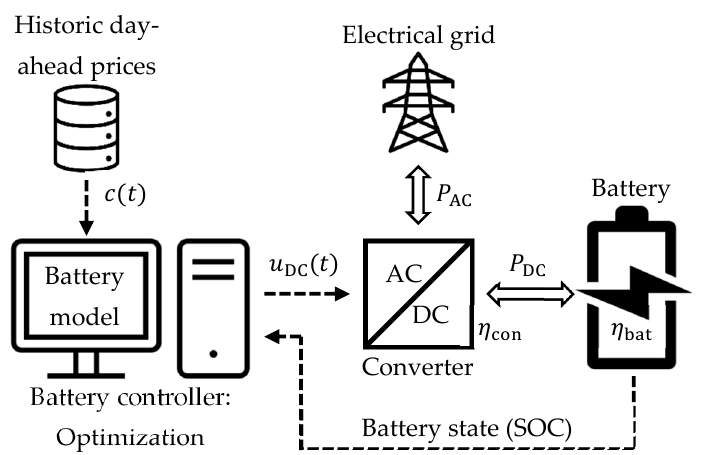
Figure 1. Battery energy storage system setup, including auxiliary, electrical components.